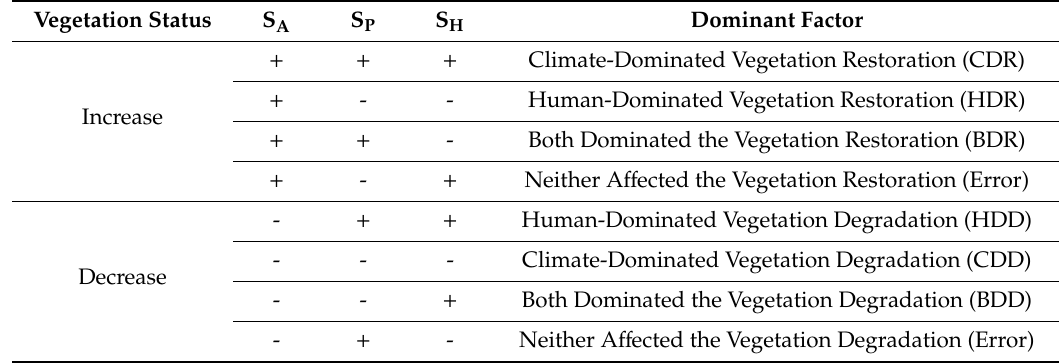
Table 2. Scenarios developed to di ff erentiate the relative contributions of human activities and climate variations in vegetation productivity change. Note: + indicates NPP increase and – refers to a decrease in